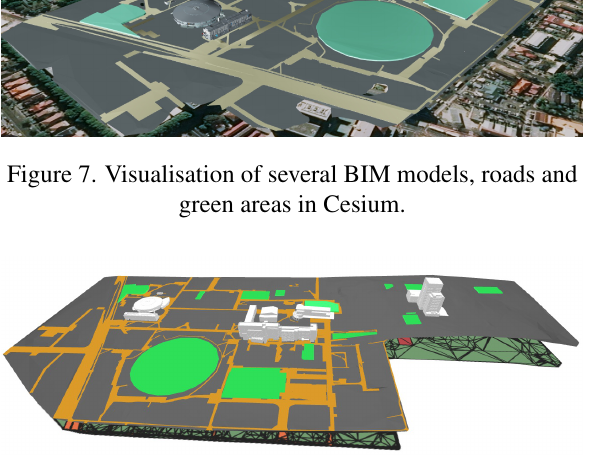
Figure 8. Visualisation of several BIM models, roads and green areas in QGIS.